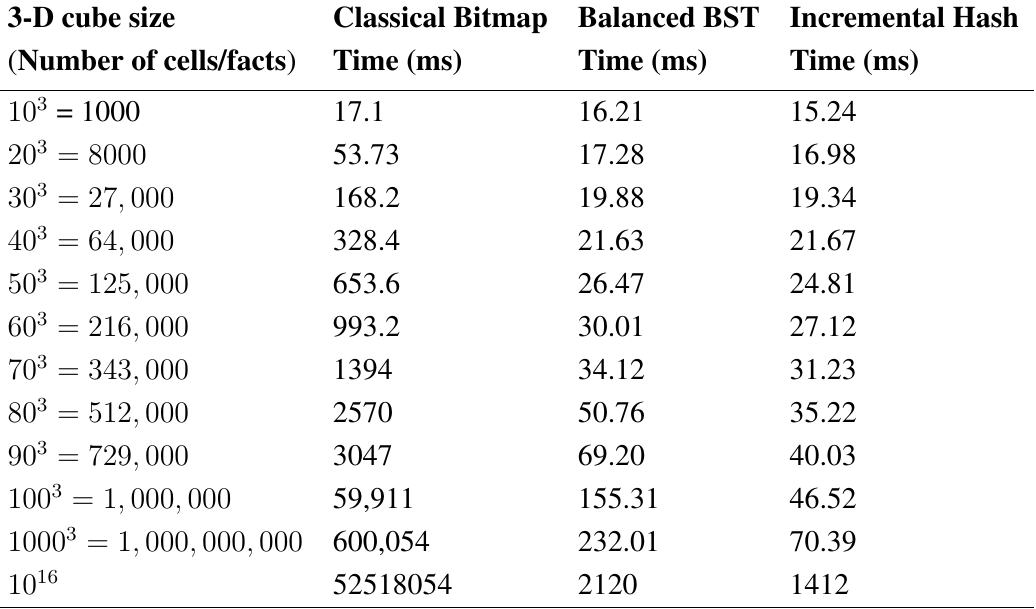
Table 1. OLAP Search time comparison.